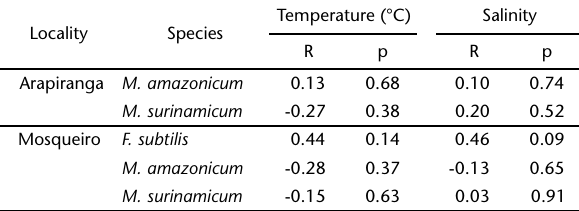
Table III. Spearman coefficients for the correlation between the density of Palaemonidae and Penaeidae shrimps and environ- mental factors on non-vegetated areas, Amazon